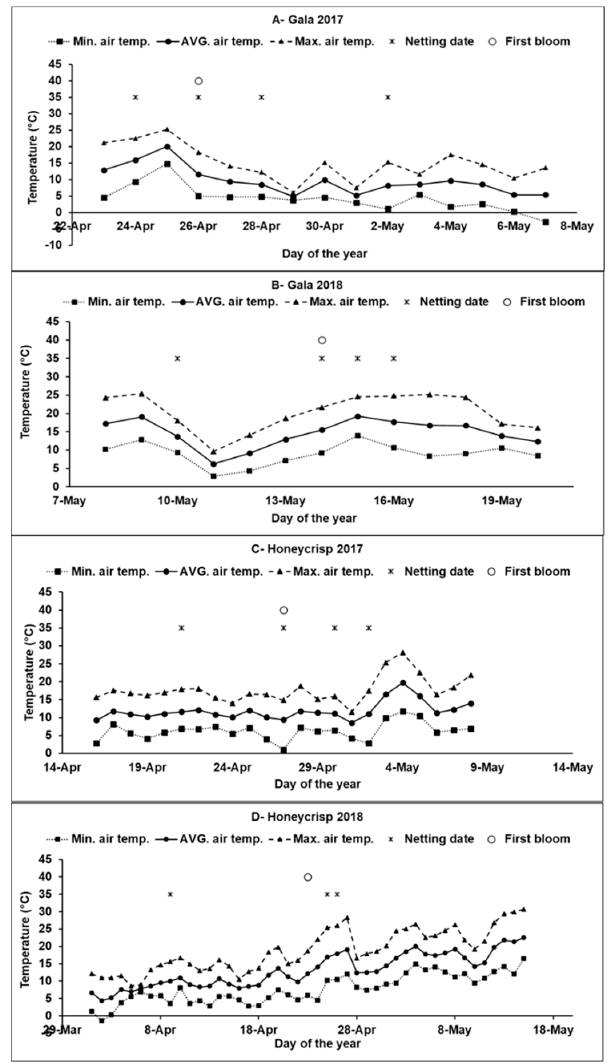
Figure 4. Maximum, minimum, and average daily air temperatures for ‘Gala’ in ( A ) Sparta,